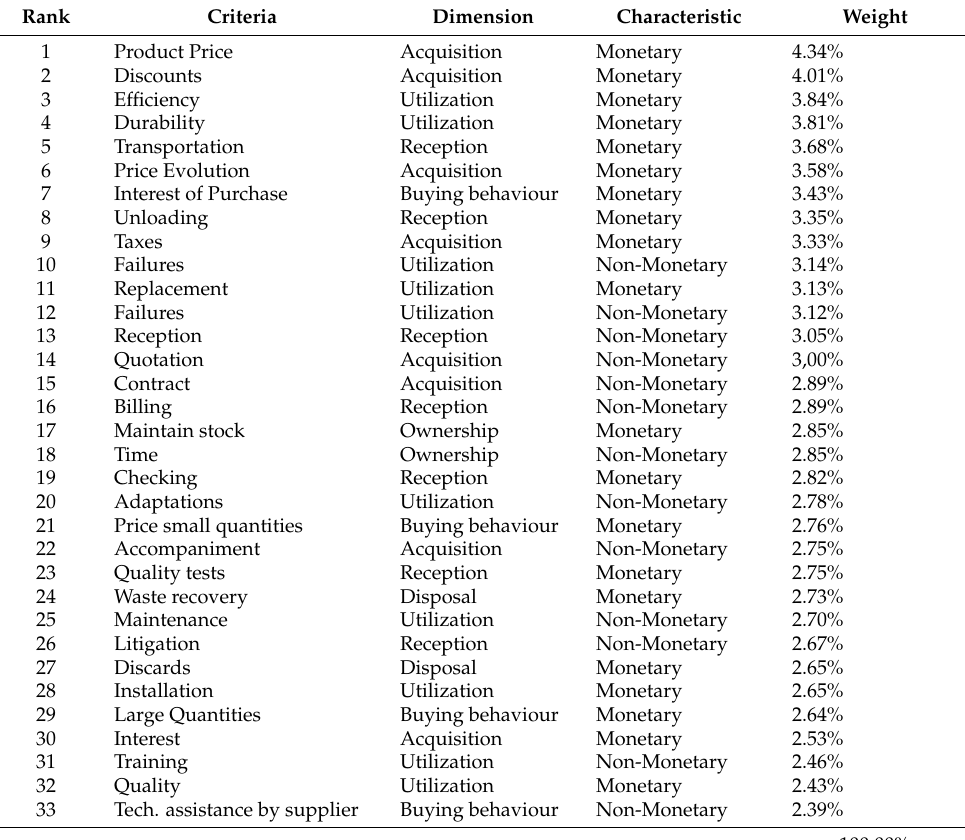
Table 2. Weights for TCO-Criteria (based on the